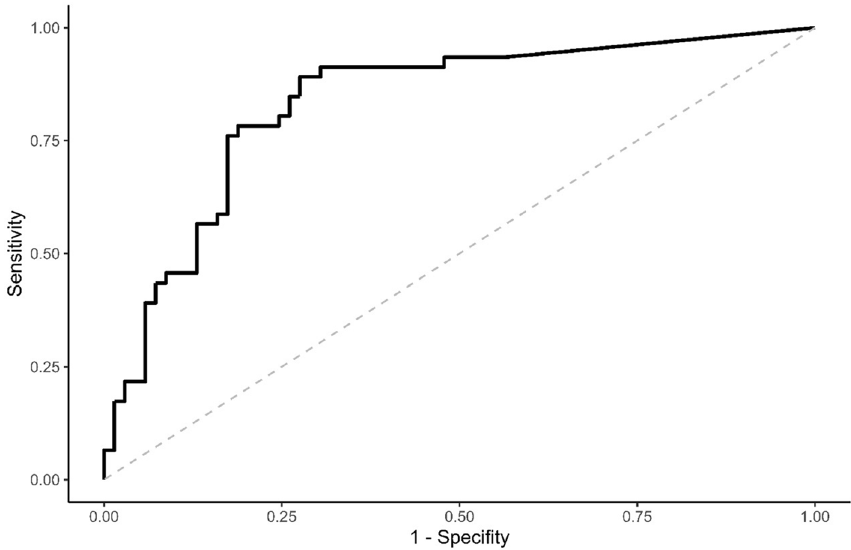
Figure 1. Receiver operating characteristic (ROC) curve for RA patients achieving low-disease activity or remission with LEF (DAS28-ESR ≤ 3.2) versus A77 1726 concentrations (n = 115). Low-disease activity or remission was defined if the patients achieved a DAS28-ESR ≤ 3.2 (low-disease activity or remission). Area under the curve = 0.83 (95% Confidence Interval; 0.76 to 0.91). Cut-off of A77 1726 concentrations was > 10.0 µg/mL, sensitivity, 91.31%; specificity, 73.91%.